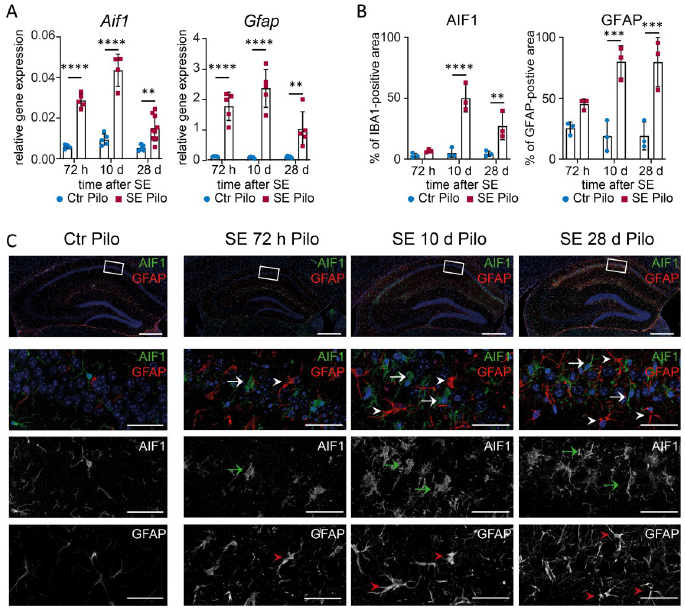
Fig 4. Sustained microglial activation and astrogliosis after pilocarpine-induced SE. ( A ) mRNA level of Aif1 (microglia) and Gfap (astrocytes) are analysed 72 h (n � 5), 10 d (n � 4) and 28 d (n � 6) after pilocarpine-induced